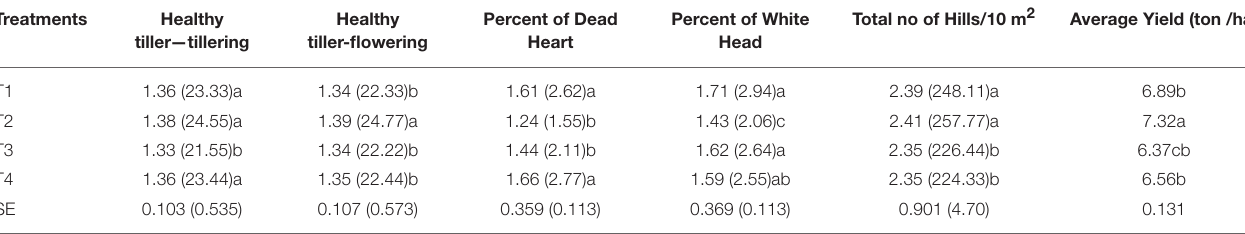
Values outside parenthesis are the transformed mean values. Numbers in parenthesis are the actual means. Letters indicate significant differences between treatments on yield components.